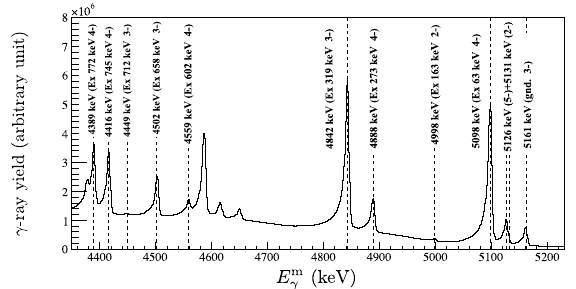
Figure 5. γ -ray spectrum measured with the La target. E γ corresponds to the energy deposited in the germanium crystals.